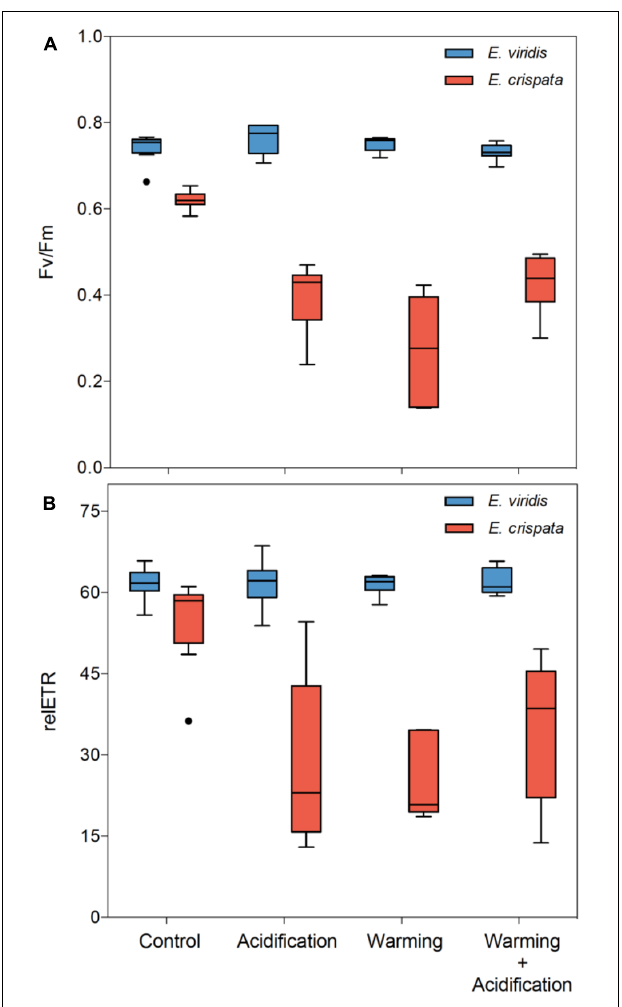
hypercapnia and heat, the negative impact of these variables was not cumulative, resulting in a significant interaction between temperature and pH ( p = 0.012 for F v /F m and p = 0.005 for FIGURE 3 | Effects of ocean warming and acidification on the photobiology of